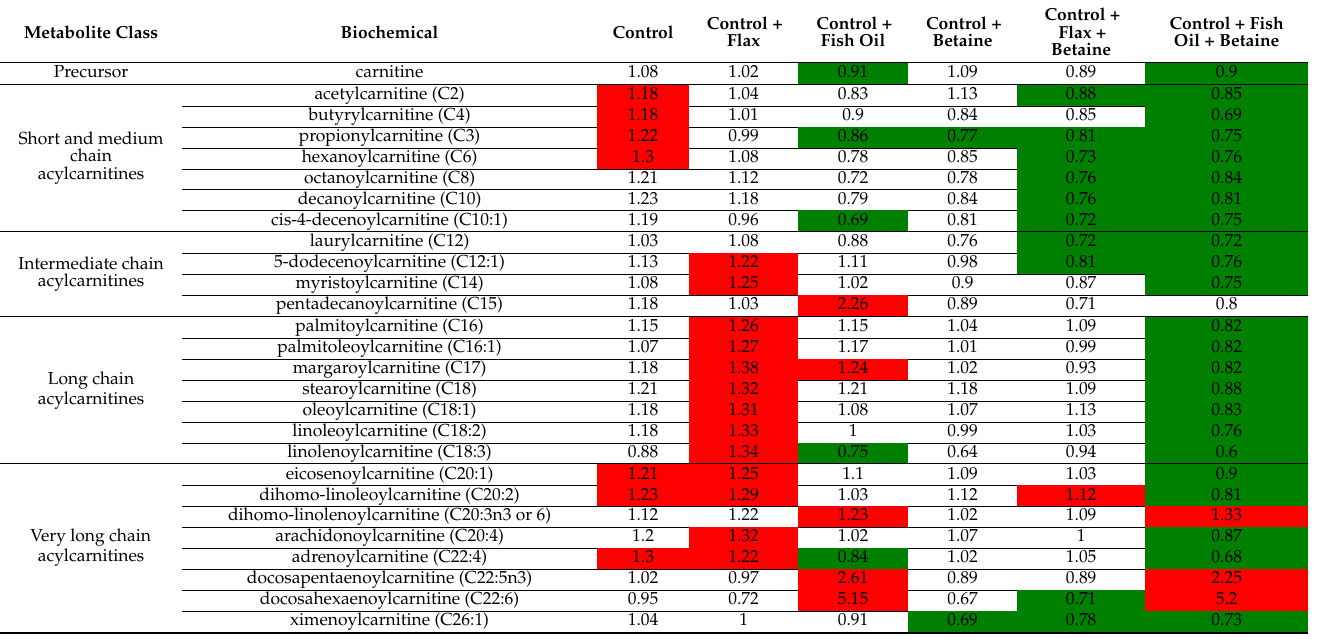
Table 7. Acylcarnitines which changed during the study while consuming control, or betaine, flax, and fish oil supplemented foods